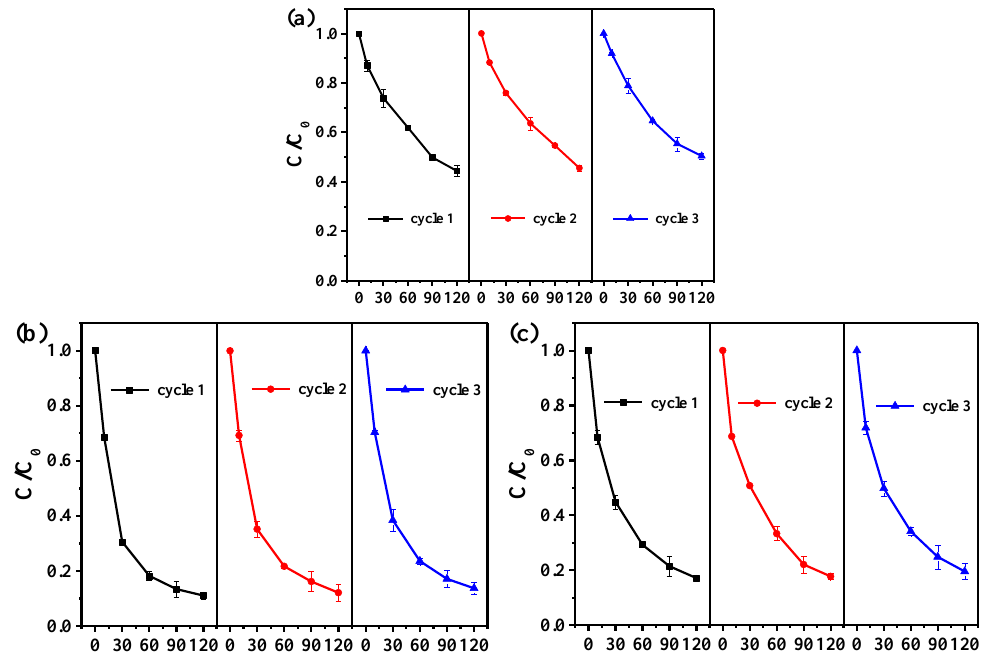
Figure 4. The three cycles of degradation of ( a ) SM2, ( b ) SMX, and ( c ) SD in mixed liquid by Bi/mZVI+CA+NaCA system.